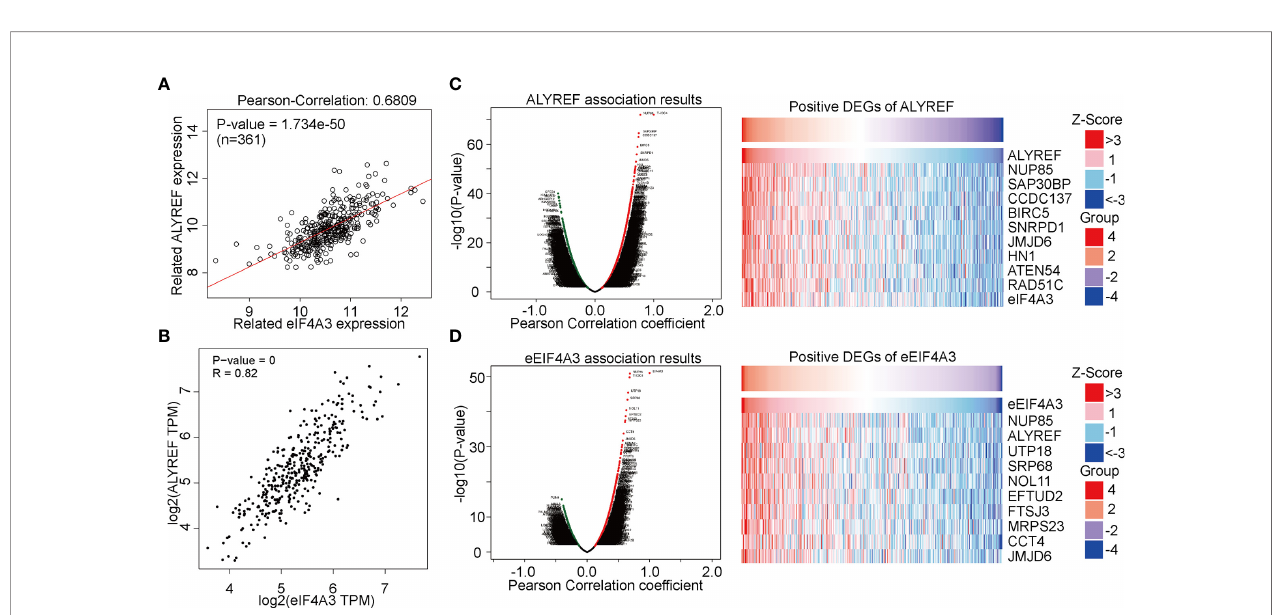
FIGURE 3 | Genomic correlations between ALYREF and eIF4A3. (A, B) ALYREF and eIF4A3 expressions were strongly correlated with each other. (C, D) ALYREF- and eIF4A3-associated differentially expressed genes (DEGs) and the top-ten